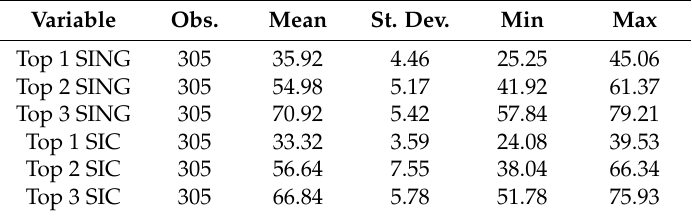
Table A4. Summary Statistics of Concentration